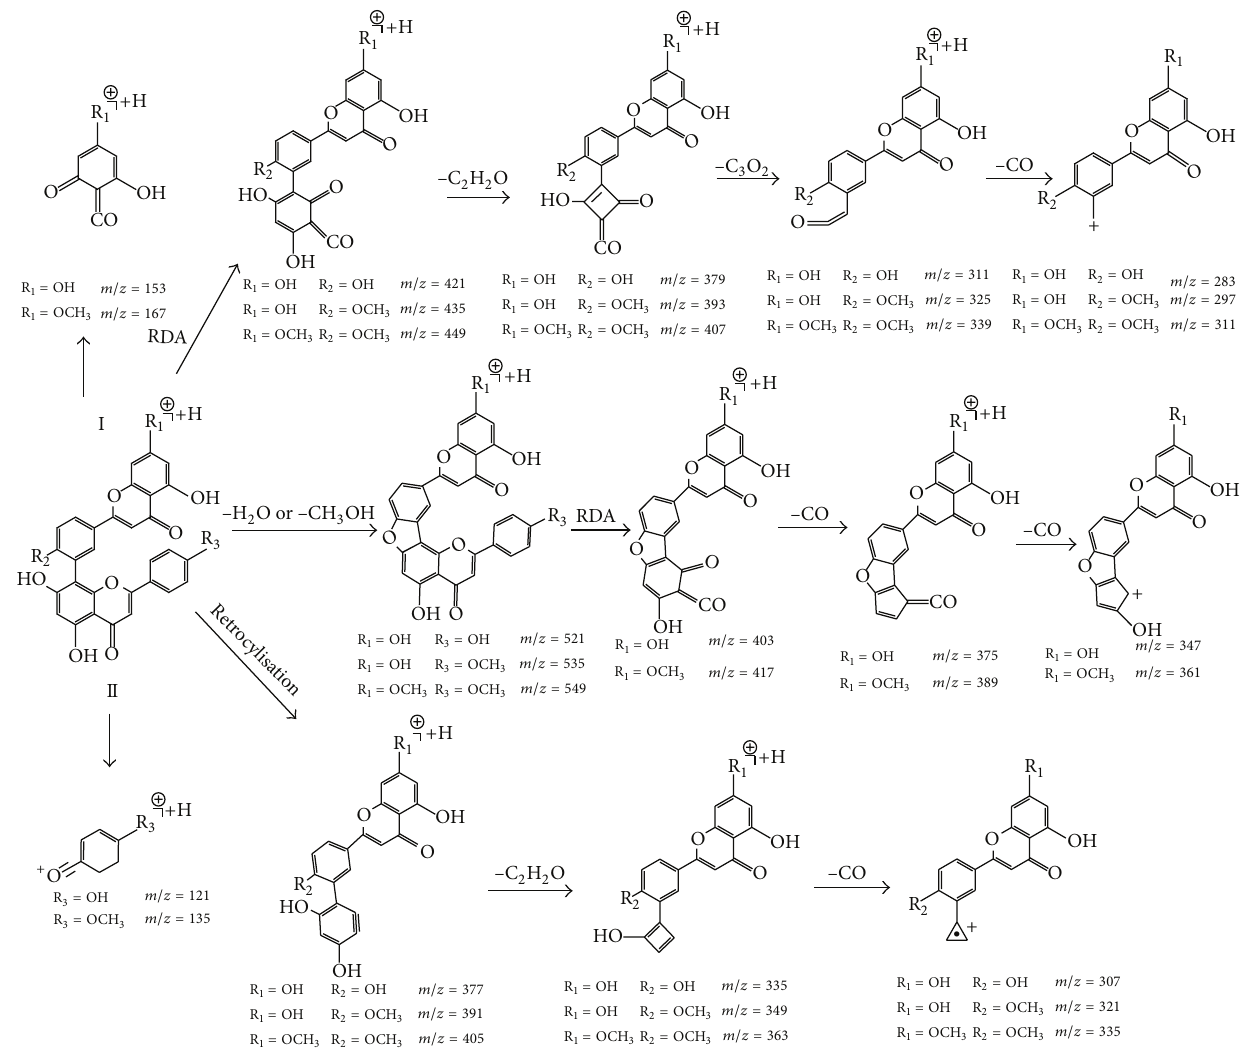
Figure 3: Proposed fragmentation pathways of amentoflavone-type biflavonoid on the basis of their MS 2 and MS 3 spectra.